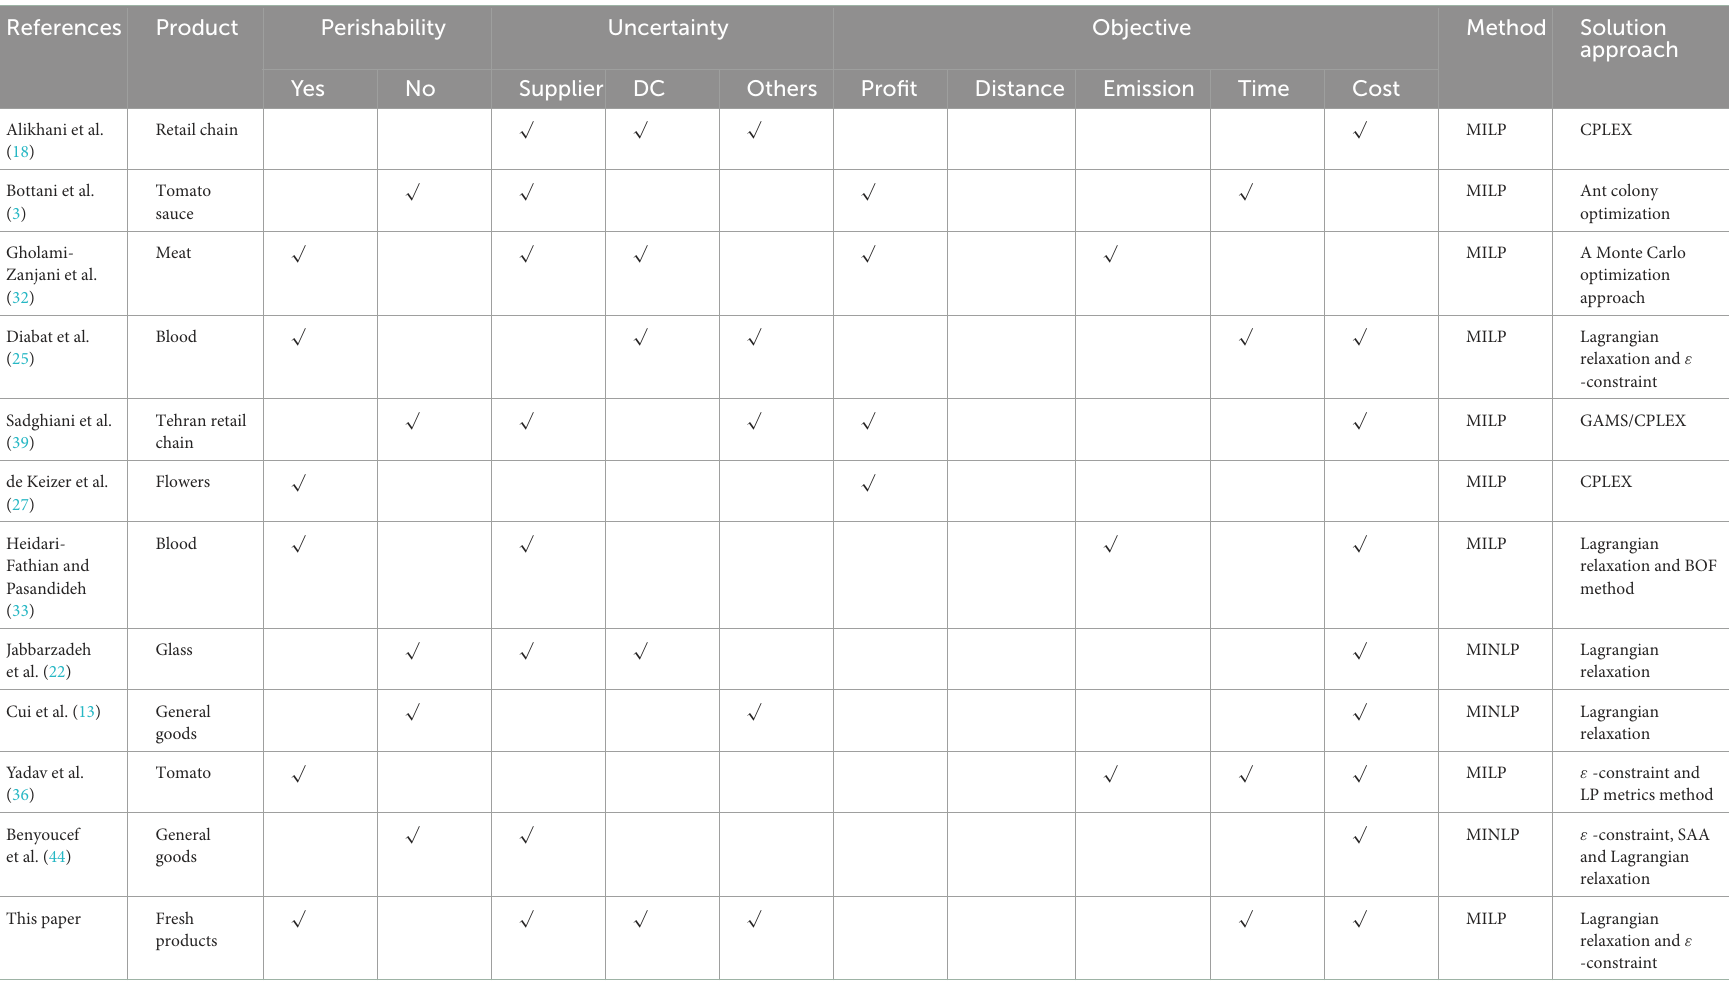
TABLE 1 Summary of the reviewed